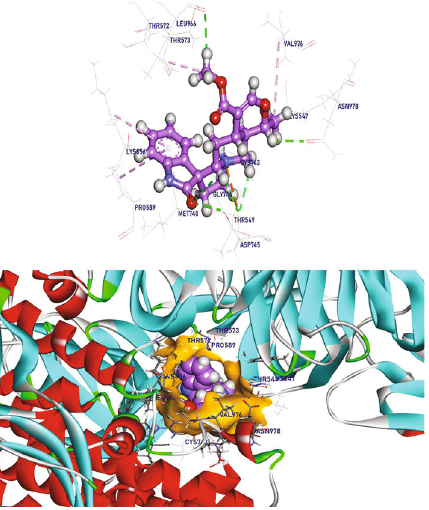
Figure 7: Isomitraphylline docked in RBD-SARS-CoV-2 Omicron spike protein, hydrogen bonds (green), and the pi interactions are represented in purple lines with mapping surface showing isomitraphylline occupying the active pocket of RBD-SARS-CoV- 2 Omicron spike